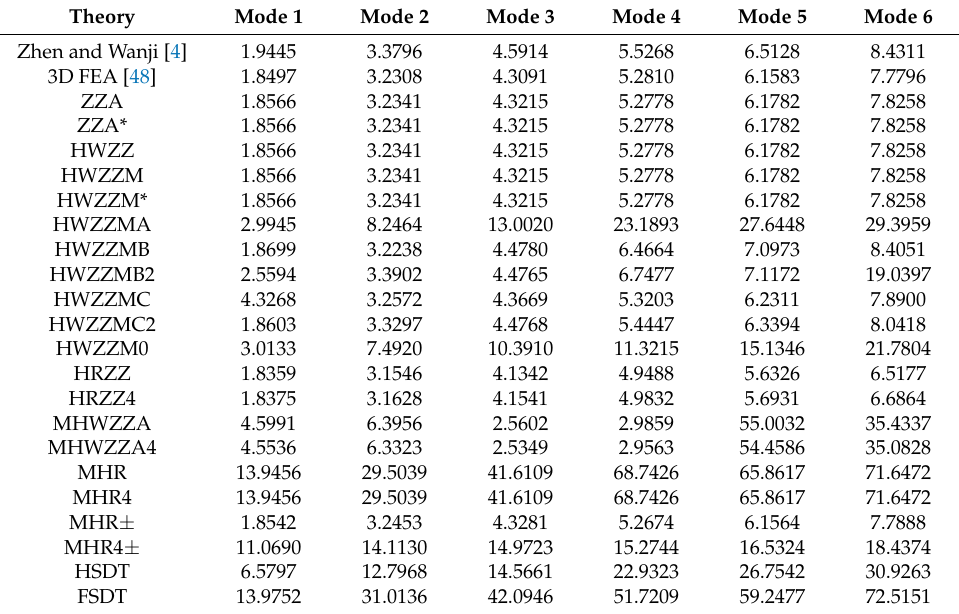
Table 16. Normalized fundamental frequencies, case